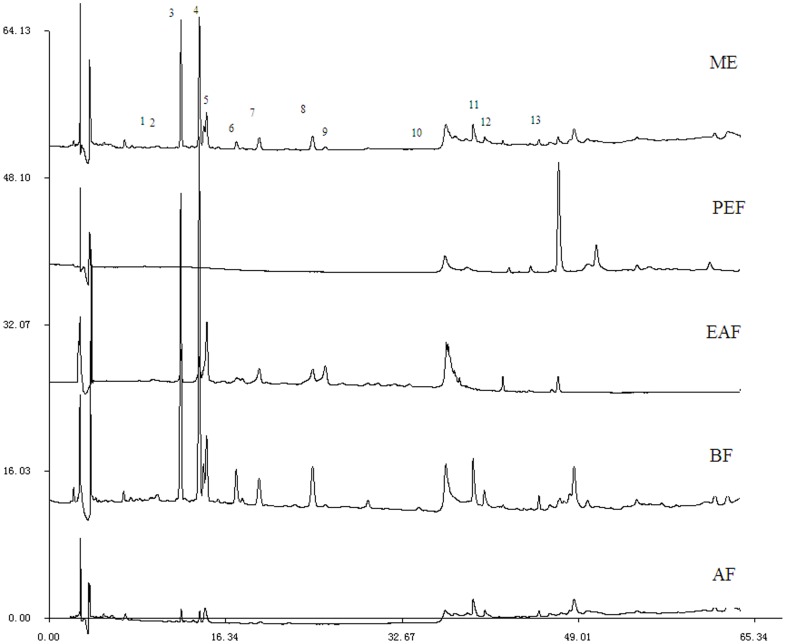
HPLC chromatograms of ME, PEF, EAF, BF, AF of CK detected at 254 nm.